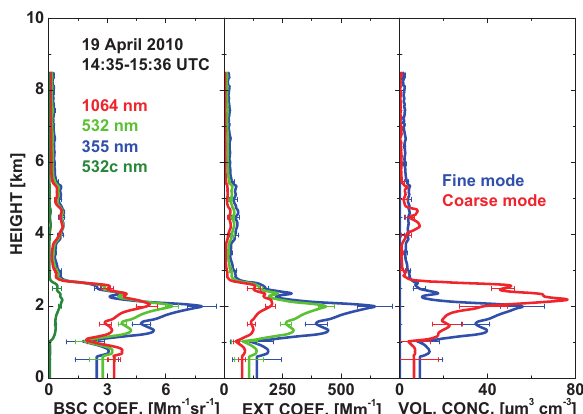
Fig. 10. Same as Figure 4, except for a volcanic dust observation on 19 April 2010. The POLIPHON curves are taken from Figure 4 Fig. 9. Same as Fig. 3 except for a volcanic dust observation on of Ansmann et al. (2012). Fig. 8. Range-corrected signal at 1064nm on 19 April 2010, 13:32– Fig. 9. Same as Figure 3, except for a volcanic dust observation on 19 April 2010, 14:35–15:36UTC with retrieval reference height of 19 April 2010, 1435–1536 UTC with retrieval reference height of z N = 8 . 25km and minimum measurement height of z N z N = 8.25 km and minimum measurement height of z N